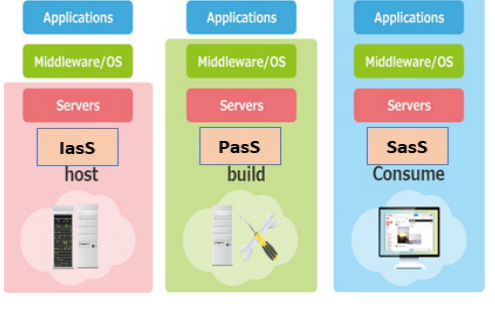
Figure 1. Deployment of Cloud Services